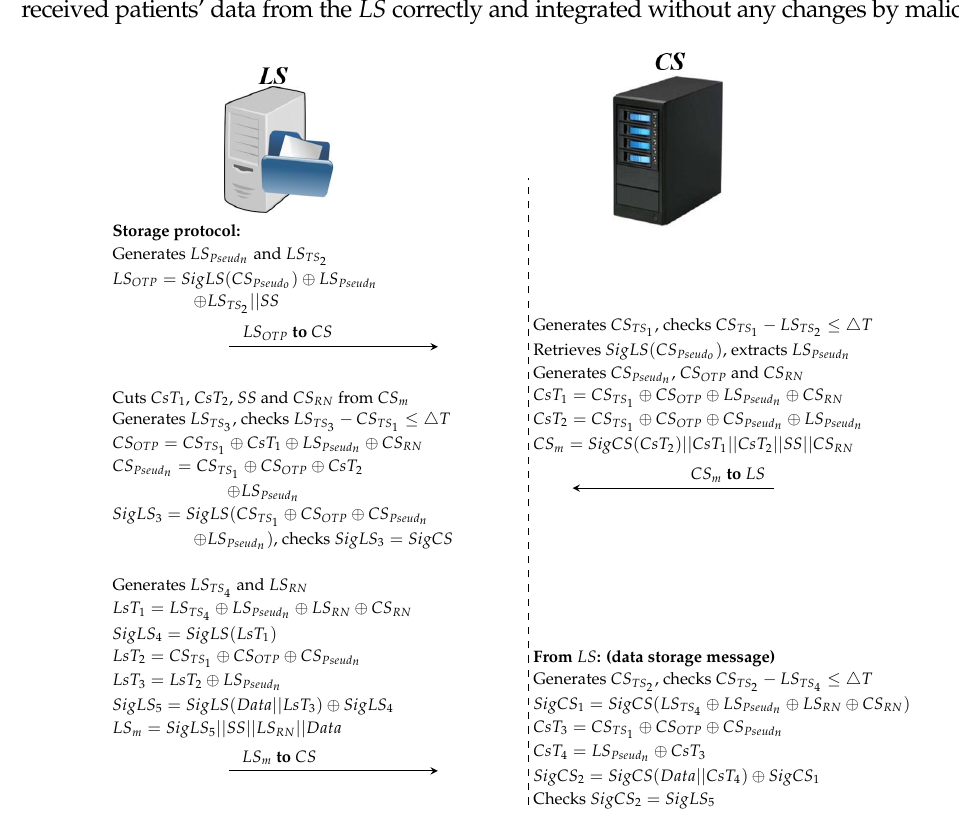
Figure 8. Data storage